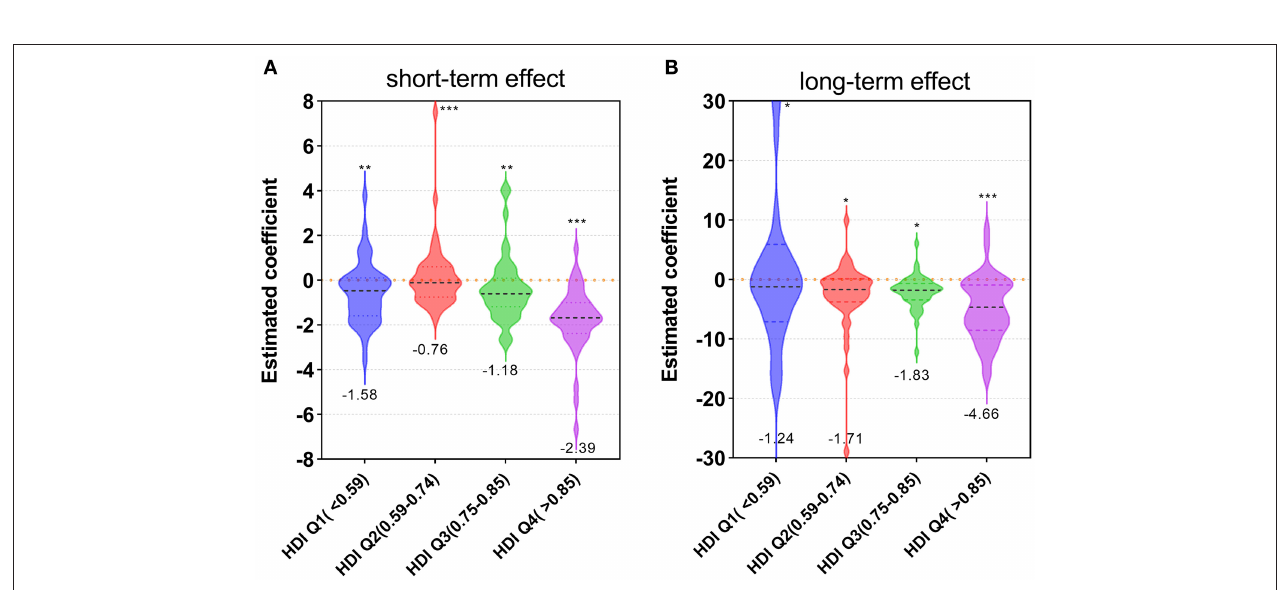
FIGURE 5 | Estimated coefficients of short-term (A) and long-term (B) effects divided by human development index (HDI) quantiles. *** means the group has a significant difference from the other three groups, ** means from the other two groups, and * means from the other group. Solid lines and numbers denote media value, and dotted lines denote quantiles 0.25 and